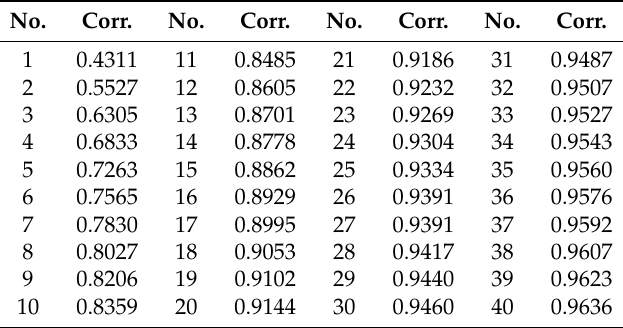
Figure 20. Pearson correlation coefficient for different random sample sizes. Table 9. Correlation coe ffi cients for each random sample